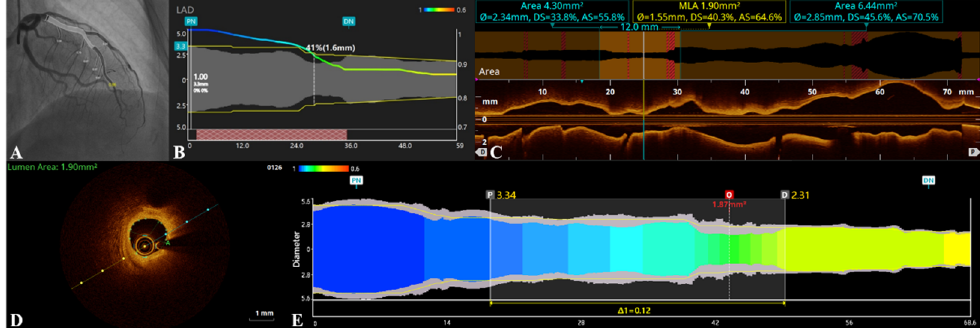
Figure 1. Computation of optical flow ratio (OFR) and quantitative flow ratio (QFR). ( A ) Coronary angiography shows the left anterior descending artery (LAD) with a single stenosis, the QFR value of this LAD was 0.88. ( B ) The virtual lumen and QFR pressure pullback at every position. ( C ) The 75-mm-long OCT pullback done across this LAD; the OCT lumen-Mode and lumen profile was shown, and the diameter of the distal reference and proximal reference measured by the OCT system was 2.34 mm and 2.85 mm, respectively. ( D ) The minimal lumen area (MLA) of LAD was 1.90 mm 2 . ( E ) The OFR software rendered a virtual pressure pullback within this LAD for optimal co-registration between pressure-drop and anatomy; the OFR value of this LAD was 0.86.